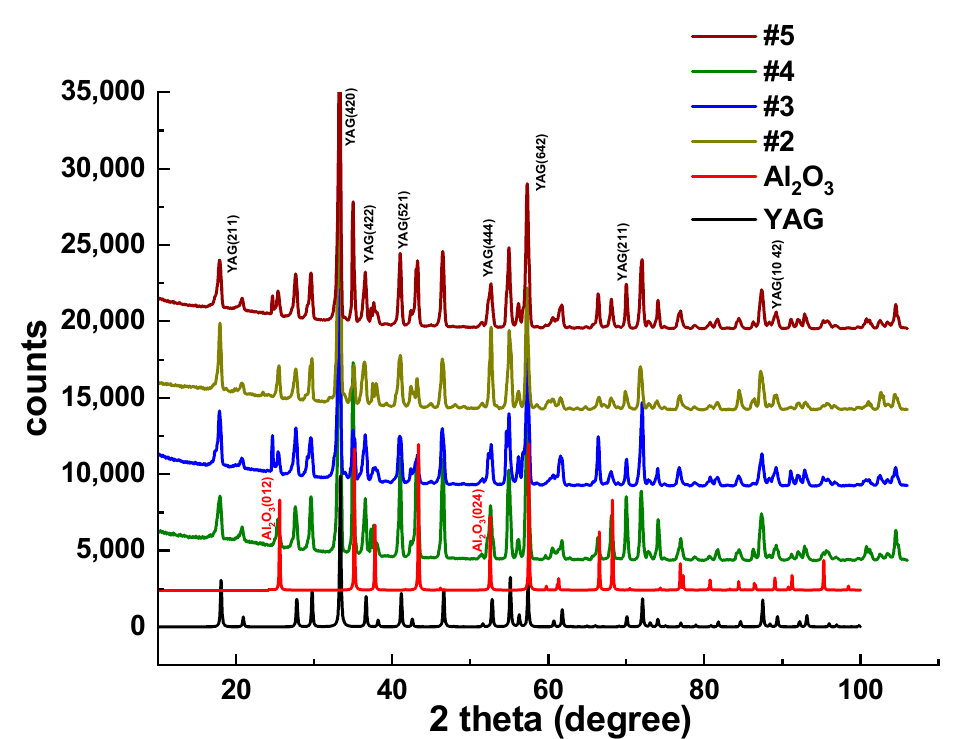
Figure 3. XRD patterns of 2–5 eutectic samples in comparison with Al 2 O 3 (ICSD #63,647) and YAG (ICSD #23,848) phases.